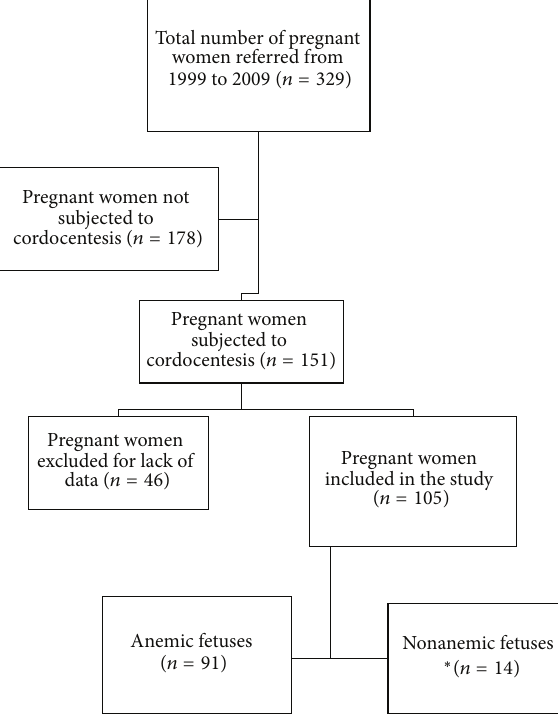
Figure 1: Flow diagram of enrolled fetuses at risk of fetal anemia from